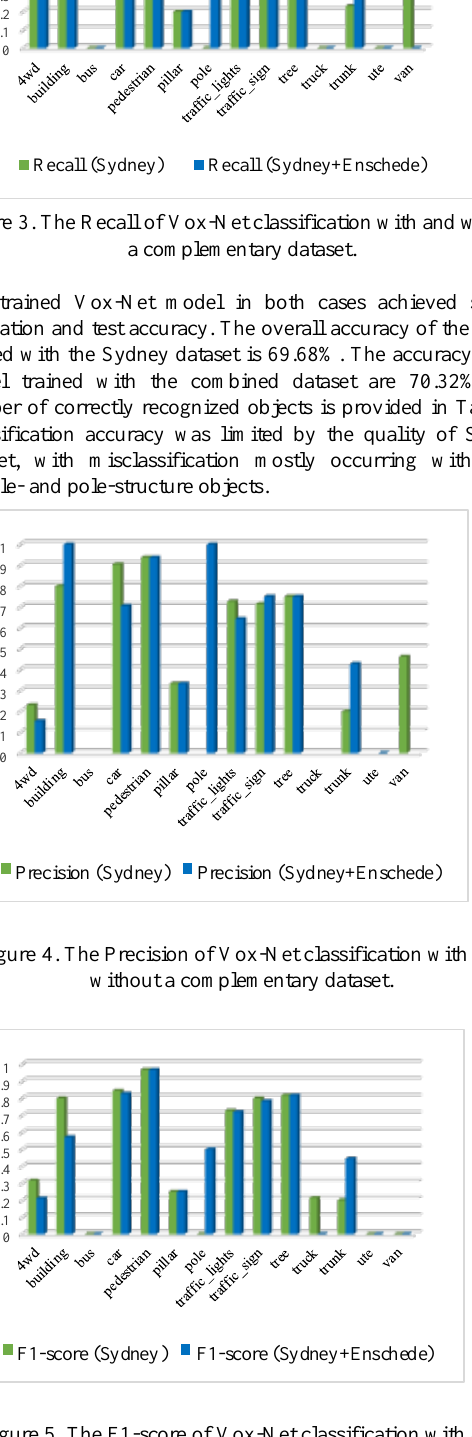
Figure 5. The F1-score of Vox-Net classification with and without a complementary dataset.